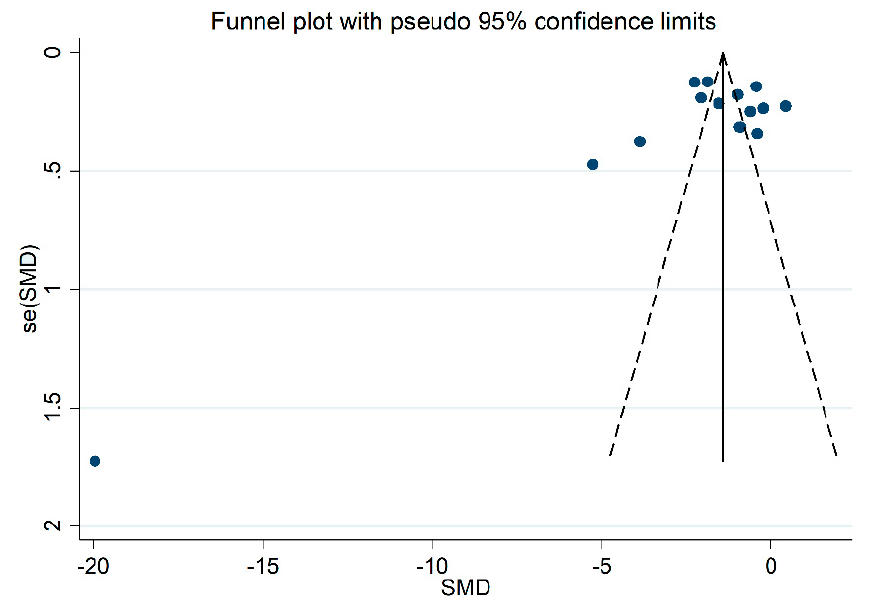
Figure 4. Funnel plot of the 15 retrieved studies evaluating the association between blood/erythrocytes GPx concentration and COPD disease.